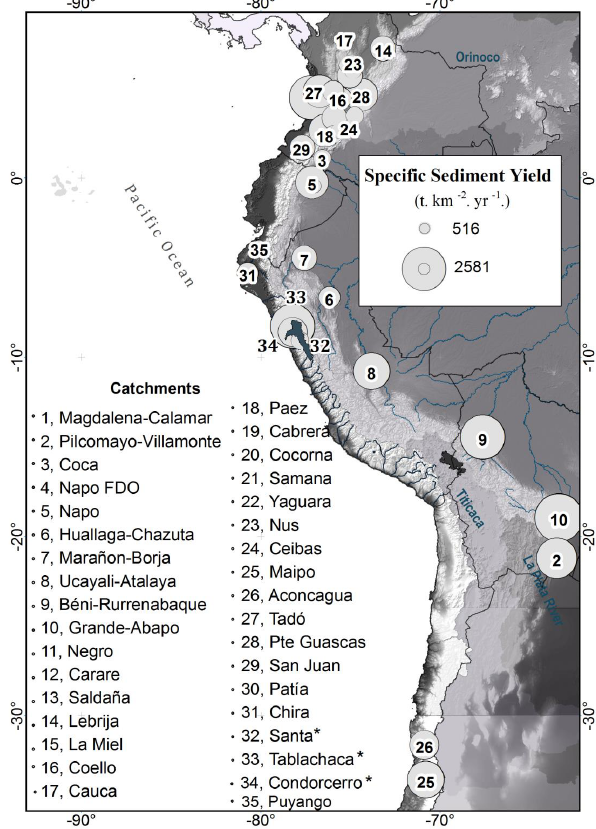
Fig. 12. The largest volumes of sediment delivered from the north- ern, central and southern cordillera of the Andes mountains. Circle Figure 12. The largest volumes of sediment delivered from the northern, central and southern 3 size corresponds to sediment yields. Numbers on the map corre- cordillera of the Andes mountains. Circle size corresponds to sediment yields. Numbers on 4 spond to data sources in Table 3. Asterisks ( ∗ ) denote study catch- the map correspond to data sources in Table 3. Asterisks (*) denote study catchments. 5